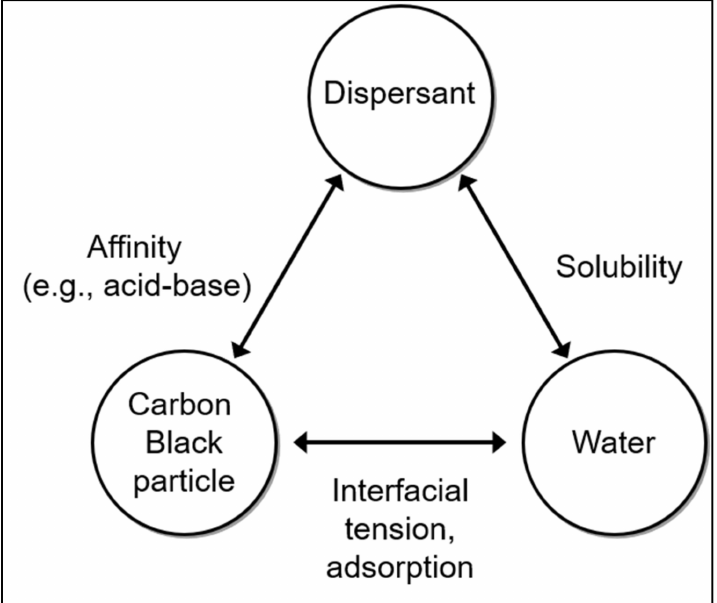
Figure 2. Three main components of aqueous CB dispersion and types of interactions affecting the dispersing of CB